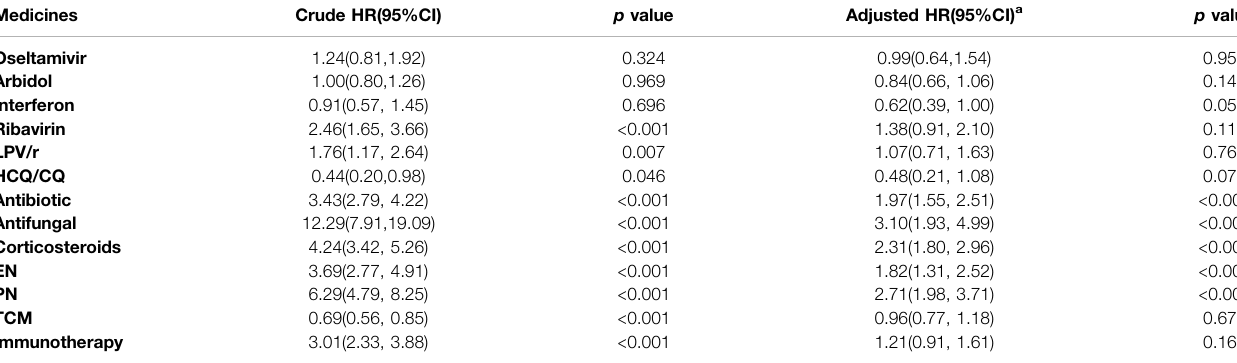
TABLE 3 | Association between hospitalized medication and risk of acute liver injury among 4010 patients with COVID-19. Medicines